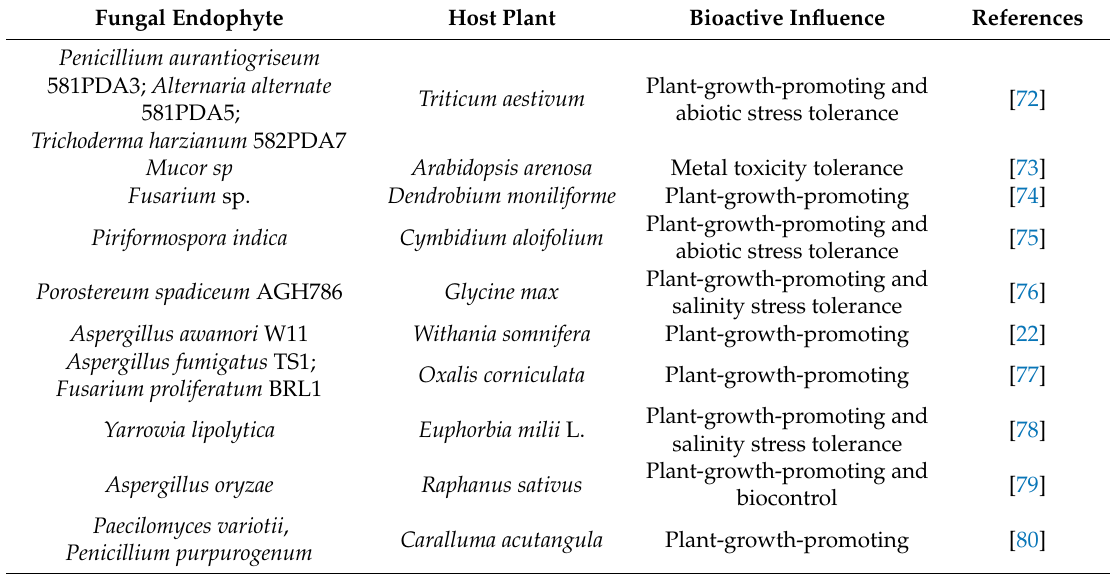
Table 2. Plant productivity enhancement using fungal